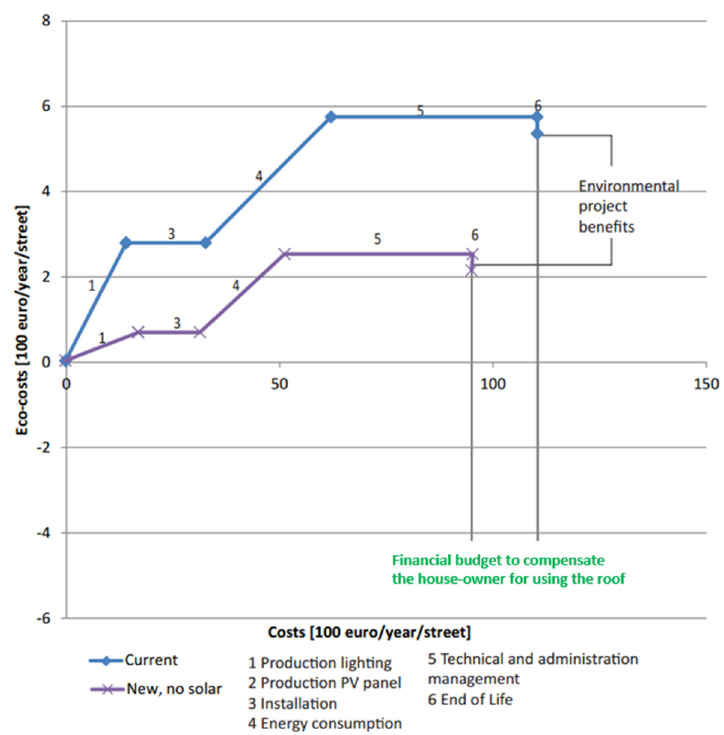
Figure 13. The rooftop lighting system (without PV cell) compared to the base case (one street one year).